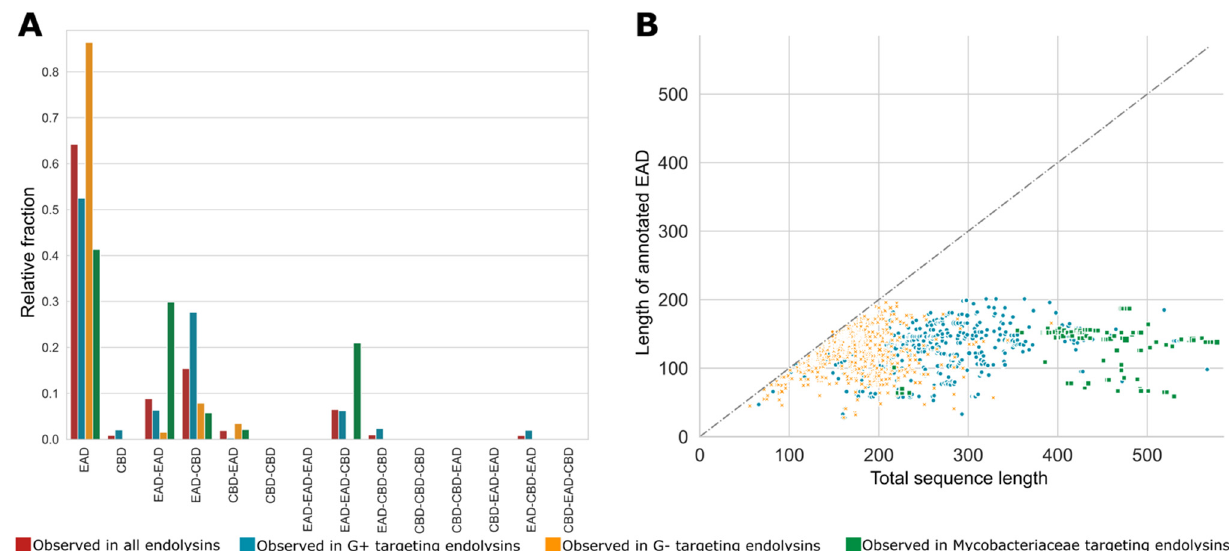
Figure 5. Relative fractions of specific single, bi- and tri-modular architectures for endolysins with different host specificities and the putative presence of unannotated domains. ( A ) The relative occurrence of each of the theoretically possible single, bi- and trimodular architecture comprising EADs and CBDs is set out for all unique endolysin sequences (red) and split up for endolysins from phages infecting Gram-positive bacteria (blue), Gram-negative bacteria (yellow) and Mycobacteriaceae (green). These fractions sum to one for each group of hosts; ( B ) the length of the annotated domain versus the total sequence length of EAD-only architectures. To accommodate for the variable numbers of repeats of a single CBD, they were condensed into a single occurrence of the domain. This analysis shows that mainly endolysins targeting Gram-positive and Mycobacteriaceae hosts comprise unannotated domains.